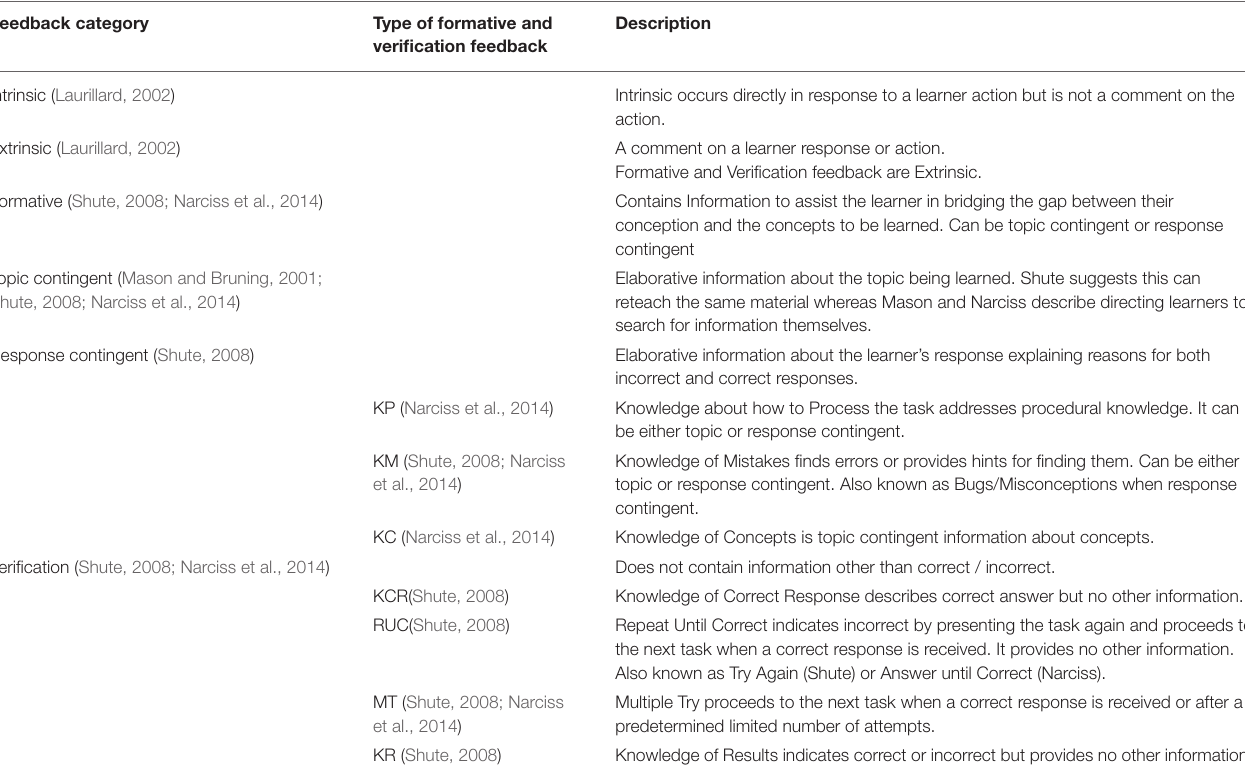
TABLE 1 | Types of feedback commonly used to teach sounds and suitable for multimedia environments, with categories in decreasing order of complexity. Feedback